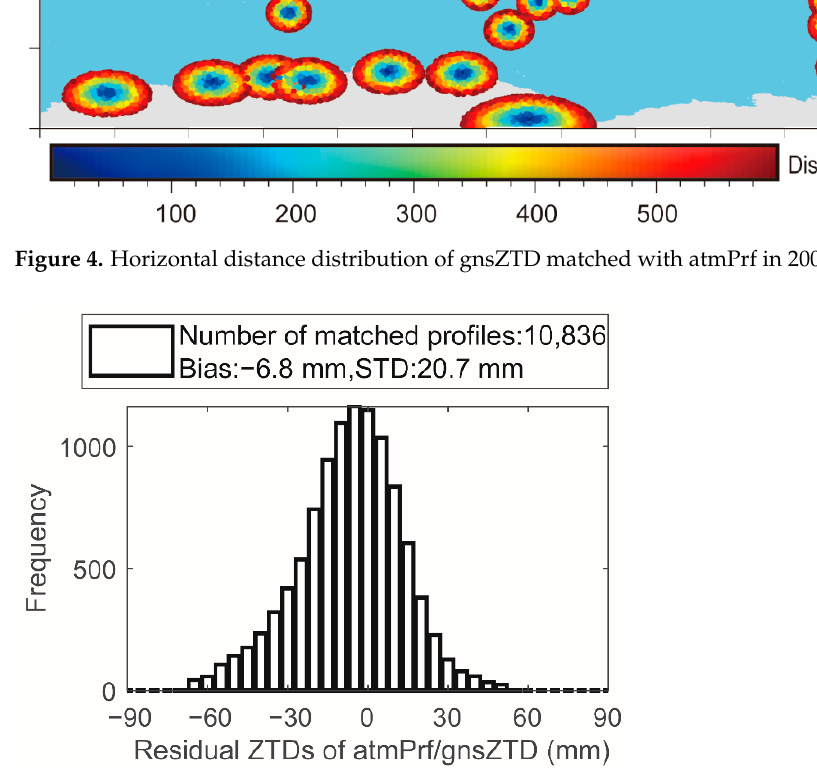
Figure 5. Statistics and distribution of residual ZTDs for matched atmPrf and gnsZTD in 2008.